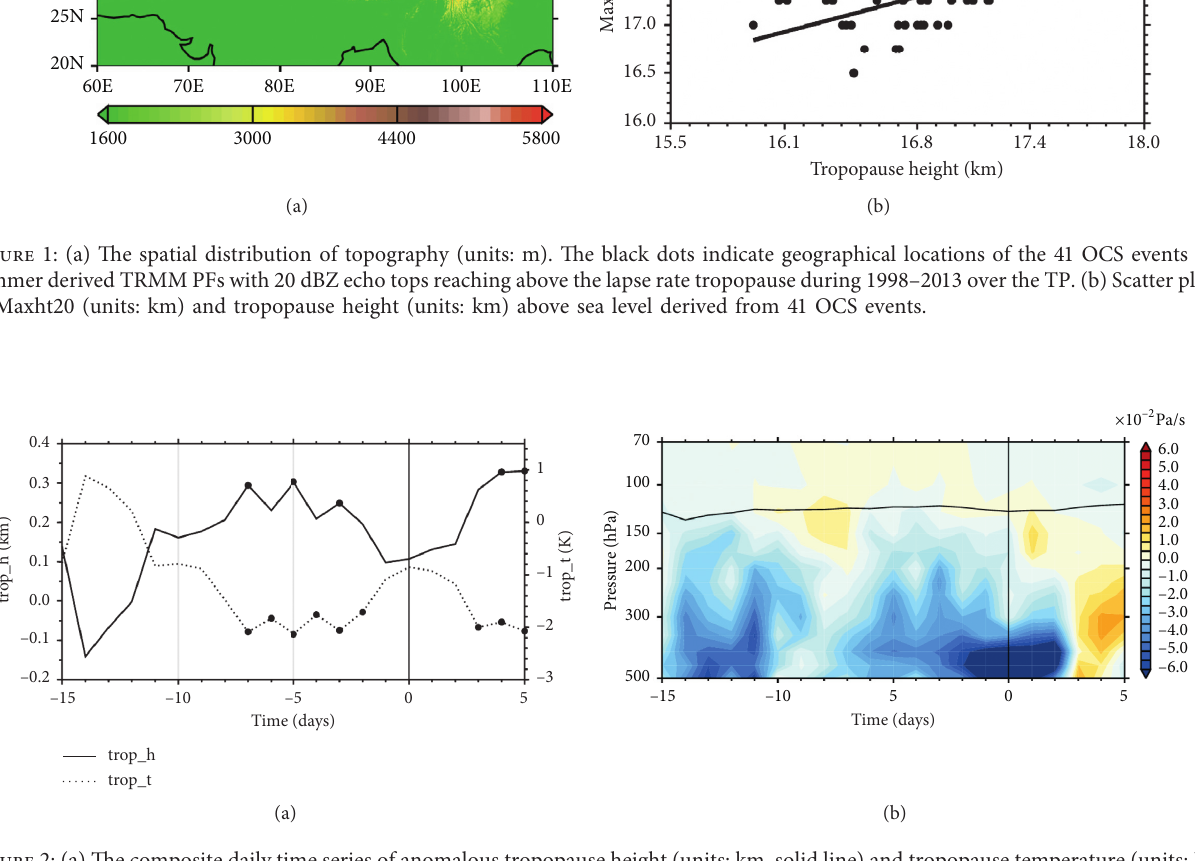
Figure 2: (a) The composite daily time series of anomalous tropopause height (units: km, solid line) and tropopause temperature (units: K, dotted line) from the 15th day before to the 5th day after the onsets of OCS for 41 OCS events. Black dots indicate that the anomalies are statistically significant at a 95% confidence level (based on a two-sided Student’s t -test). (b) Composites of time-pressure cross section of the vertical velocity (units: 10 − 2 Pa/s) from the 15th day before to the 5th day after the OCS onset for 41 OCS events. The horizontal black solid line represents the tropopause height; the vertical black solid line indicates the day of the OCS